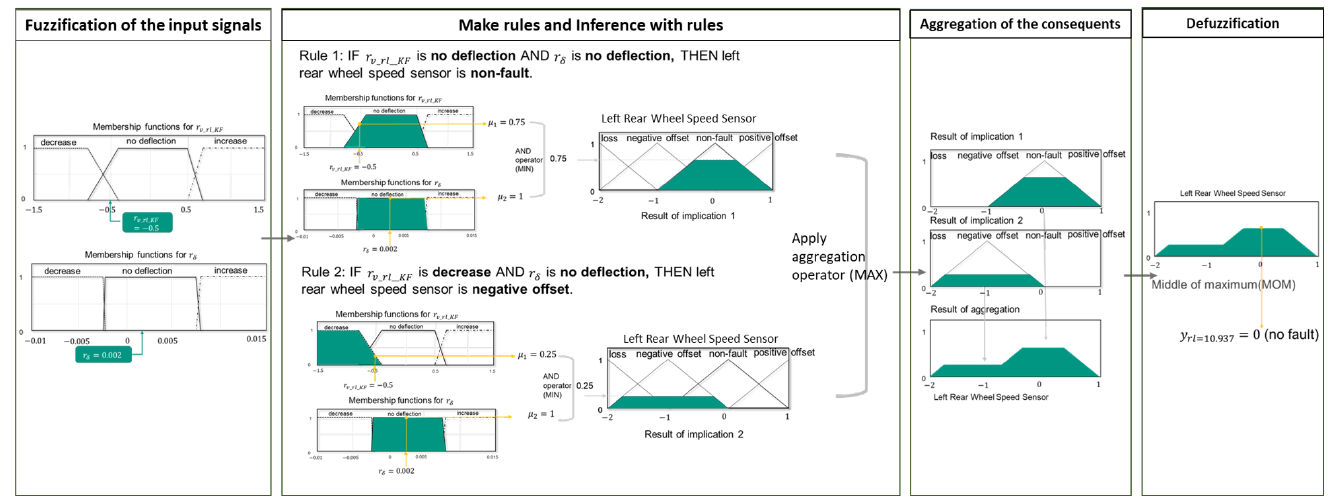
Figure 2. Fuzzy process